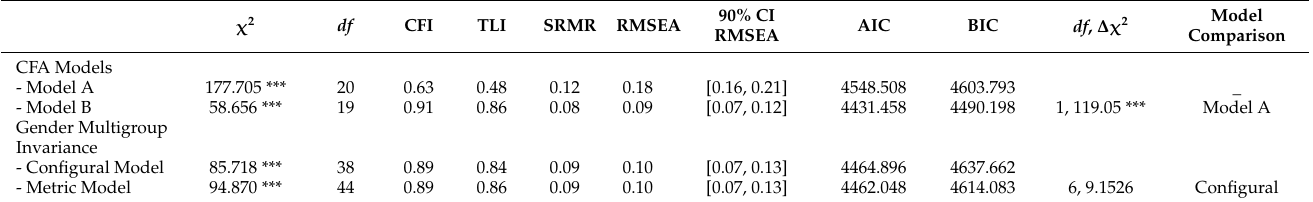
Table 3. Goodness-of-fit statistics for the CFA and multigroup invariance models (N = 234).